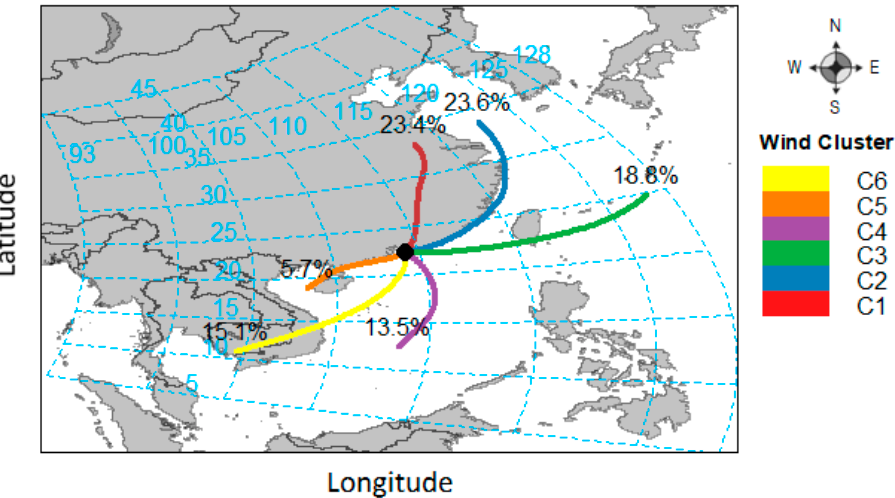
Figure 5. A 6 cluster solution when performing cluster analysis on all back trajectories from July 3rd to November 14th, using NOAA’s Hysplit, merged with the Openair package. Each trajectory represents 120 h and start from a height of 10 m above ground level.